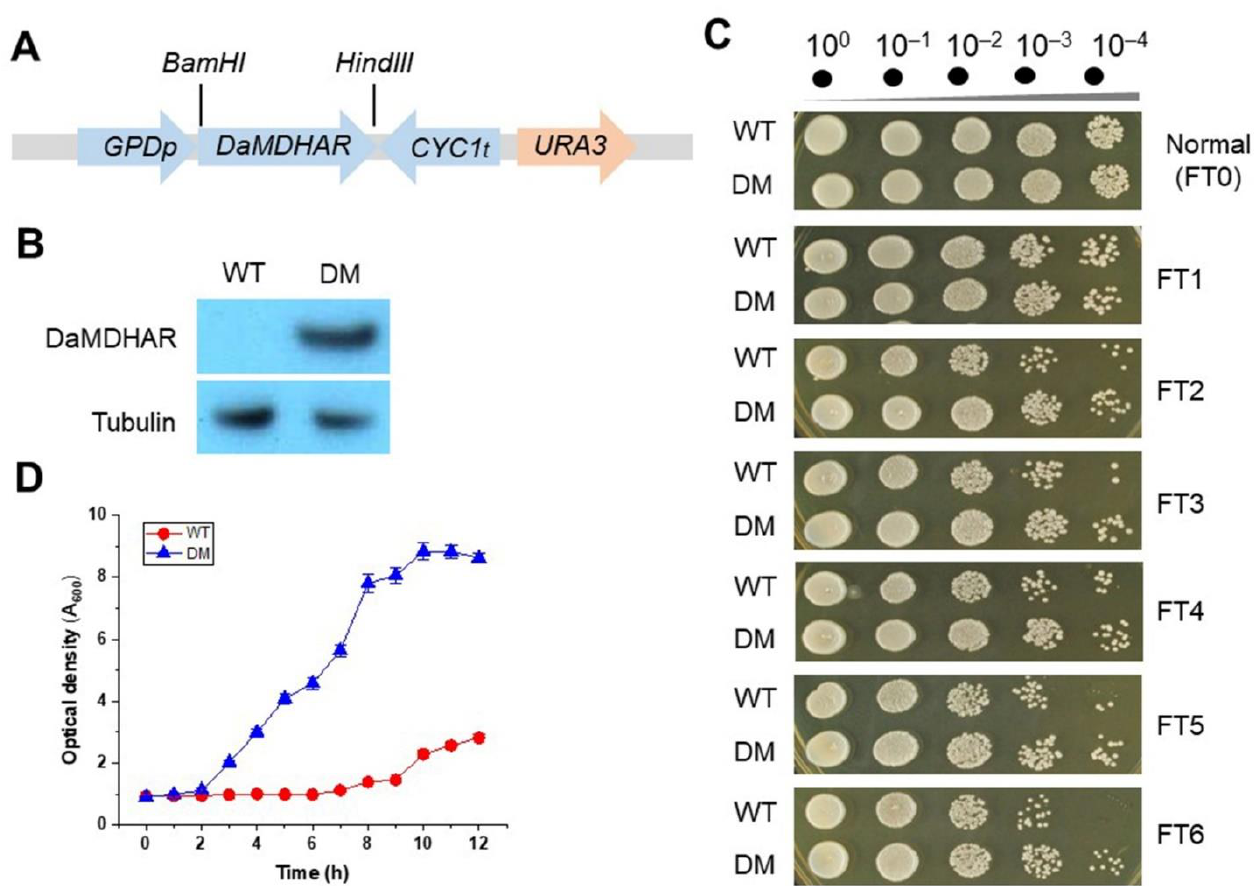
Figure 1. Cellular response in cDNA encoding MDHAR ( DaMDHAR )-expressing transgenic yeast cells to freezing